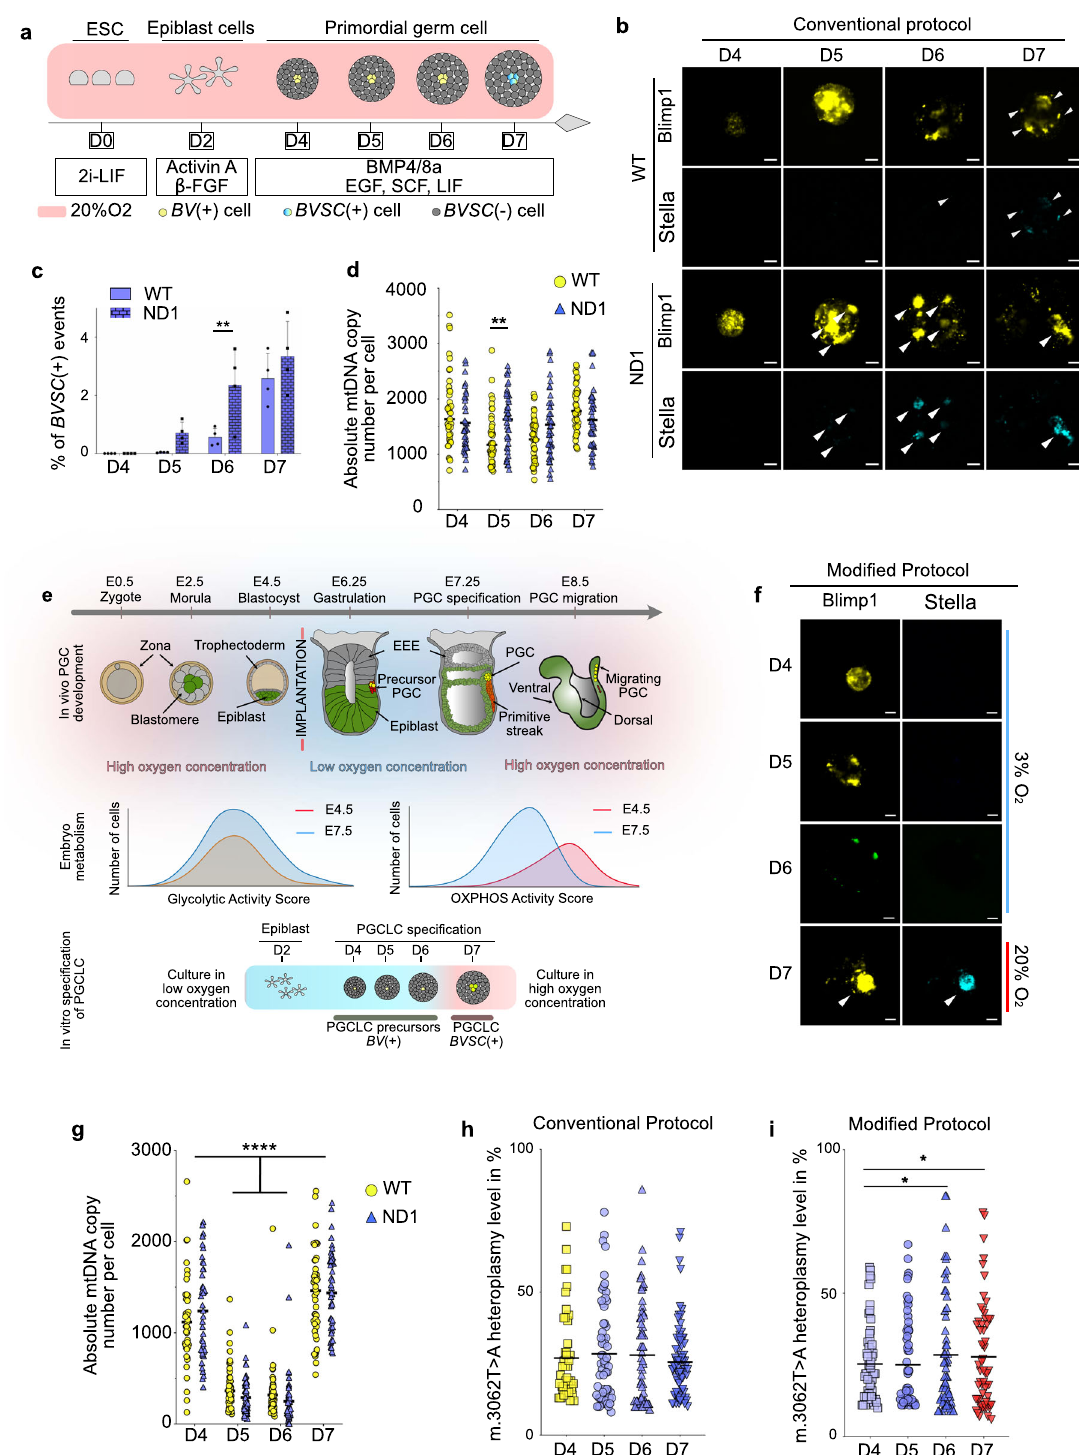
bottleneck during differentiation, we used the modi fi ed protocol (Figs. 1e, f and S3a) to isolate BV ( + ) (from D4 to D6) and BVSC ( + ) (at D7) cells by fl uorescence-activated cell sorting (FACS) from both the WT and ND1 lines from 4 independent experiments (Fig. S3b – d). Analysis of the mtDNA content in single cells measured from WT BV ( + ) cells showed an ~4-fold decrease in the mean mtDNA content from 1119 (SD: ±495 copies) at D4 to 319 (SD: ±300 copies) at D6 (Fig. 1g and Supplementary Data 1). We saw a similar pattern for the